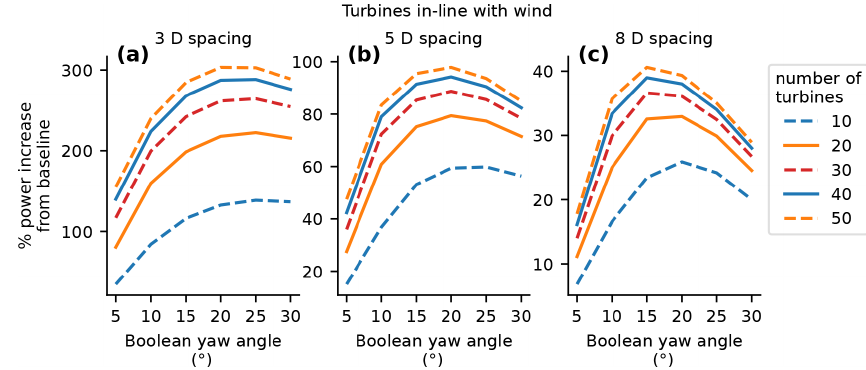
Figure 2. The absolute percent improvement over the nonyawed baseline for the Boolean problem approach and optimization methods as a function of the Boolean yaw angle. Each panel shows the percent improvement as a function of the number of wind turbines in the power plant for Boolean yaw angles between 5 and 30 ◦ . Panels (a) – (c) present power plants with different turbine spacings of 3, 5, and 8 rotor diameters,